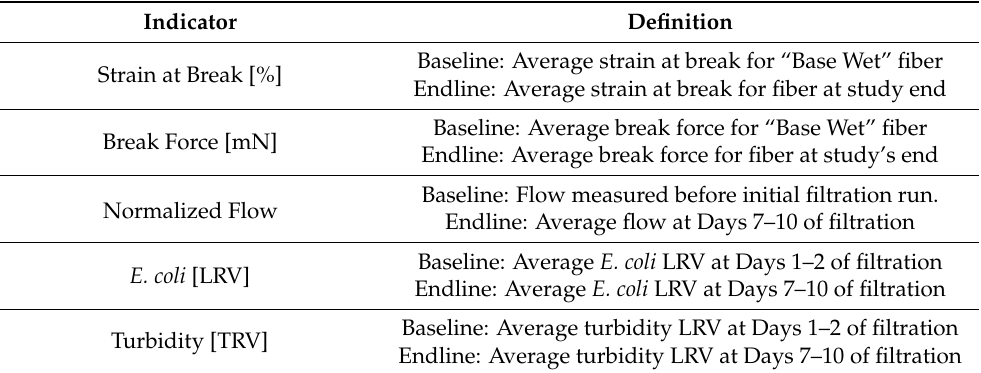
Table 1. Definition of baseline and endline